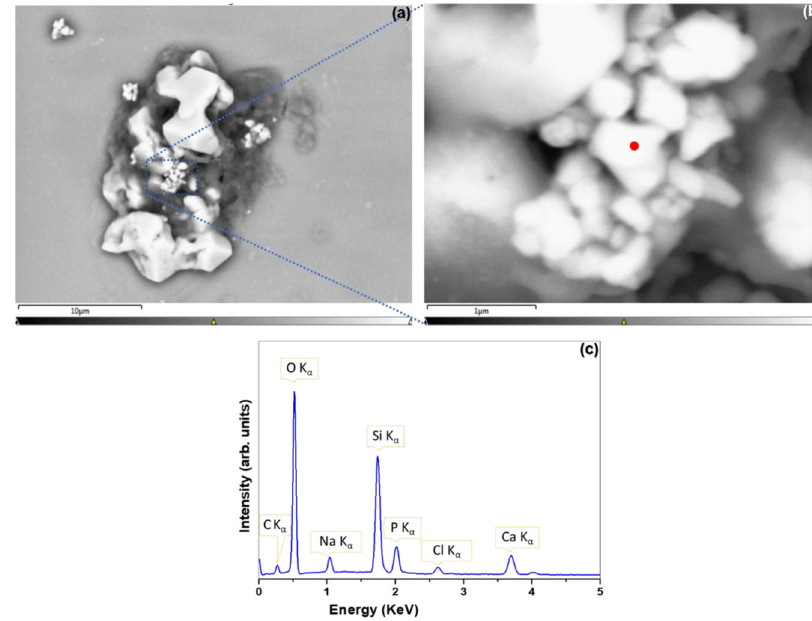
Fig. 9 SEM image (main image) along with corresponding elemental maps (Ca and P) from quartz substrate for single U-2 OS cell derived from TI-HA-ANN after 21 days in culture under standard conditions. Scale bar represents 10 µm distance within main